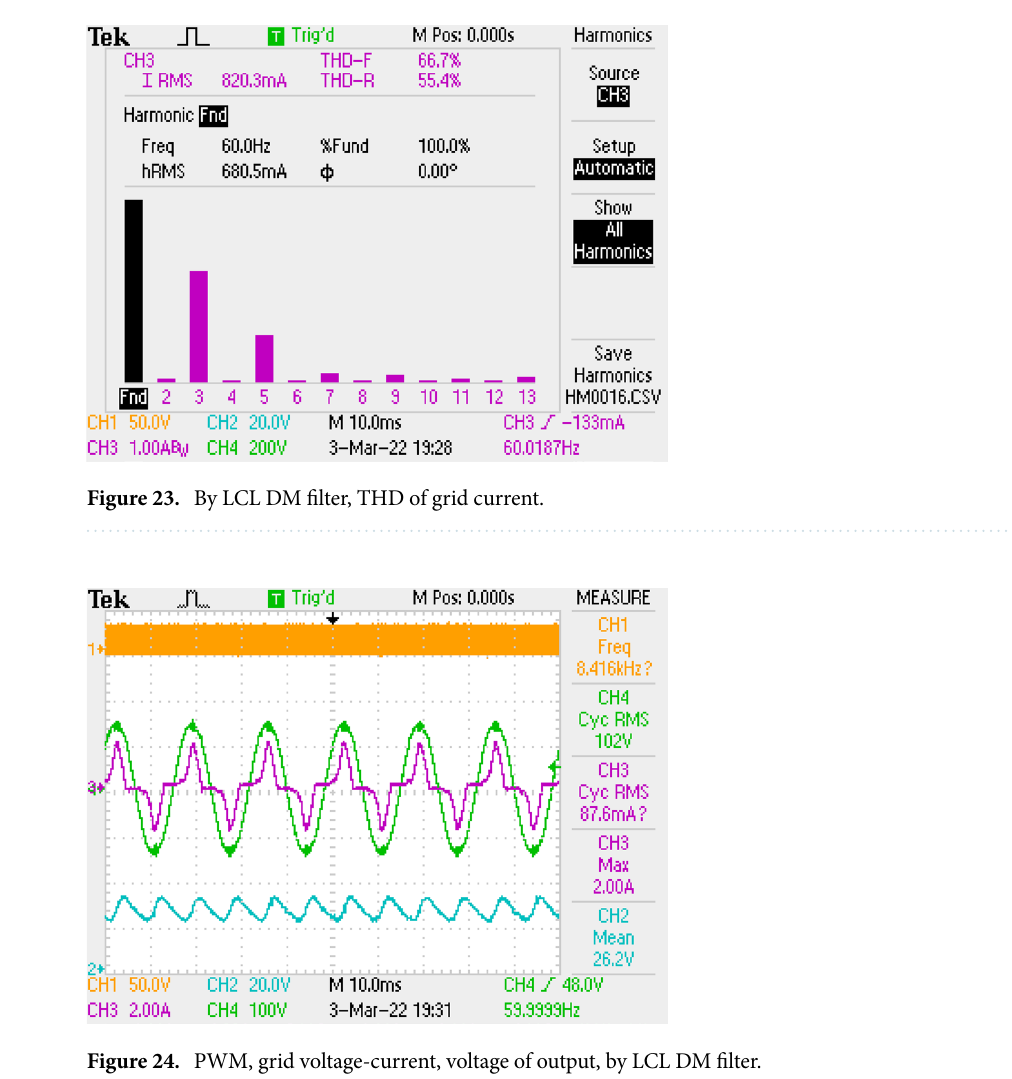
Figure 24. PWM, grid voltage-current, voltage of output, by LCL DM